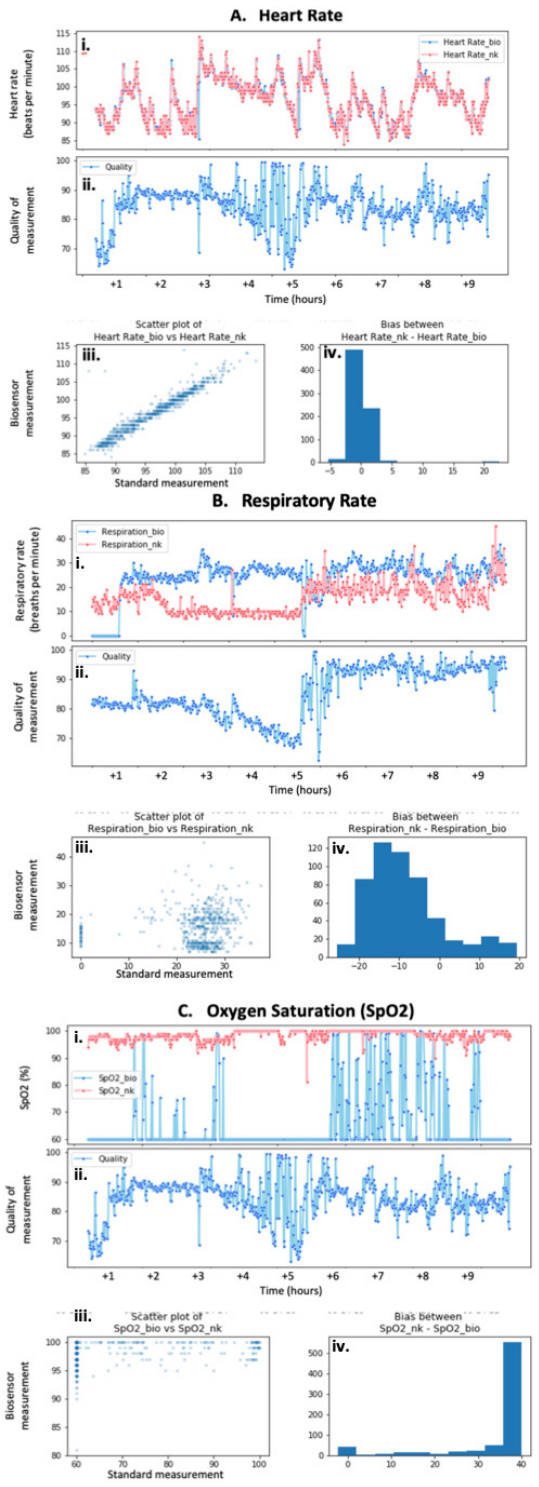
Figure 1. Correlation between data supplanted by multimodal sensor and standard ICU monitoring. Various degrees of data consistency were demonstrated by biosensors ranging from excellent for heart rate measurements ( A ), to variable for respiratory rate observations ( B ), to suboptimal SpO 2 recordings ( C ). In addition to the vital signs measured ( i ) and the quality of the biosensor measure- ments ( ii ), the correlation ( iii ), and bias ( iv ) between biosensor and Nihon Kohden recordings were also reported according to vital